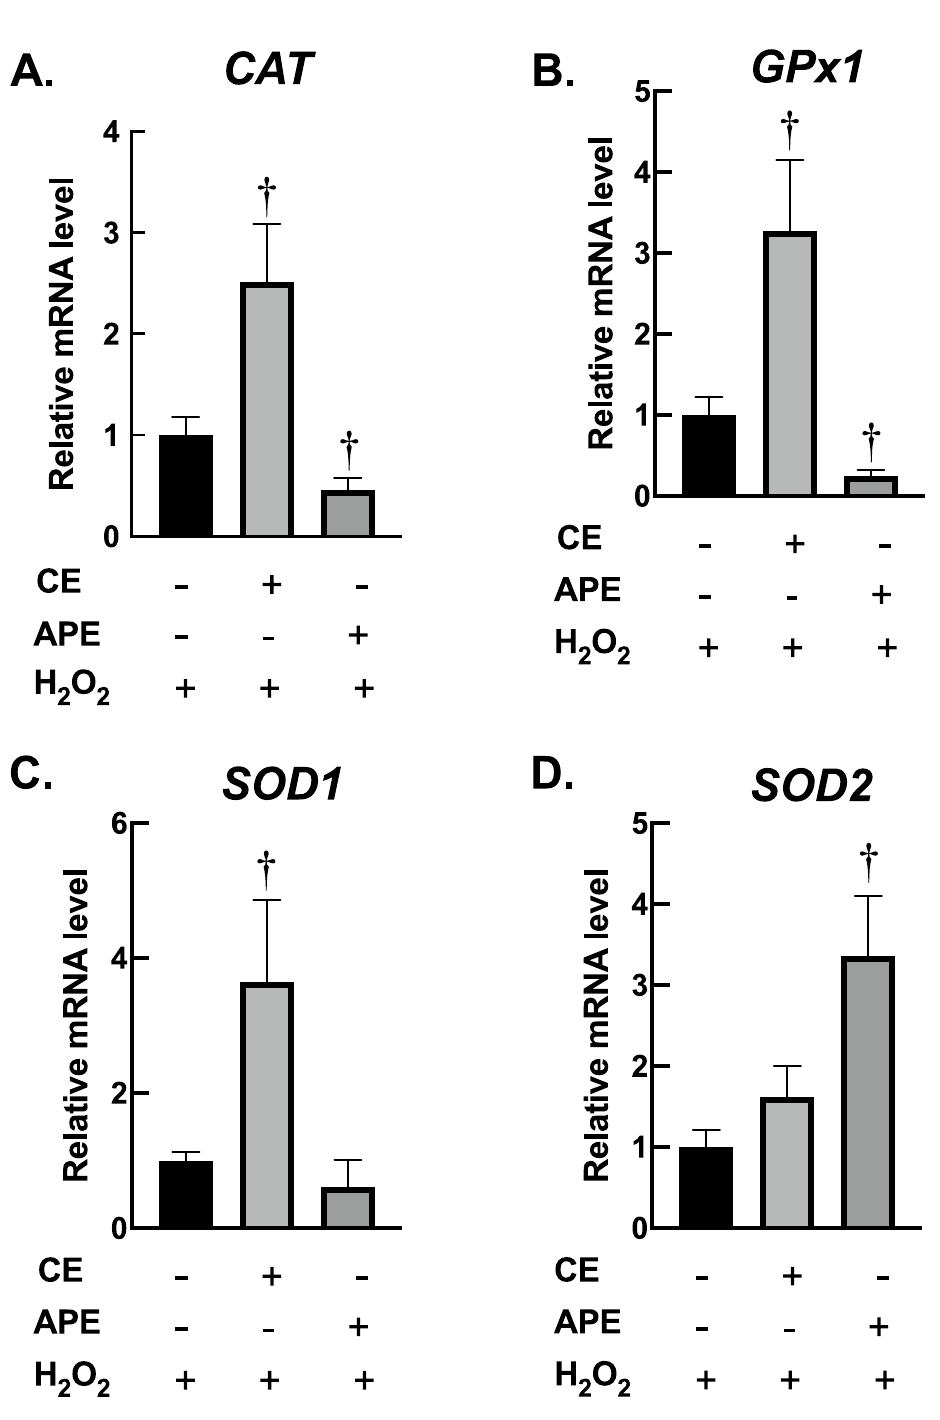
Figure 6. Centella extracts promote expression of antioxidant enzymes following H 2 O 2 treatment. ( A – D ) In response to H 2 O 2 treatment, CAT , GPX1 and SOD1 expressions were increased in CE-treated fibroblasts, while SOD2 transcription were elevated in APE-treated fibroblasts. BJ cells were incubated with CE (60 µg/mL; 24 h) or APE (60 µg/mL; 24 h), then exposed to H 2 O 2 (200 µM; 1 h). The transcriptional levels of CAT , GPx1 , SOD1 , and SOD2 , were evaluated with RT-PCR following treatments ( n = 3; mean ± SEM; † P < 0.05 vs H 2 O 2 -treated